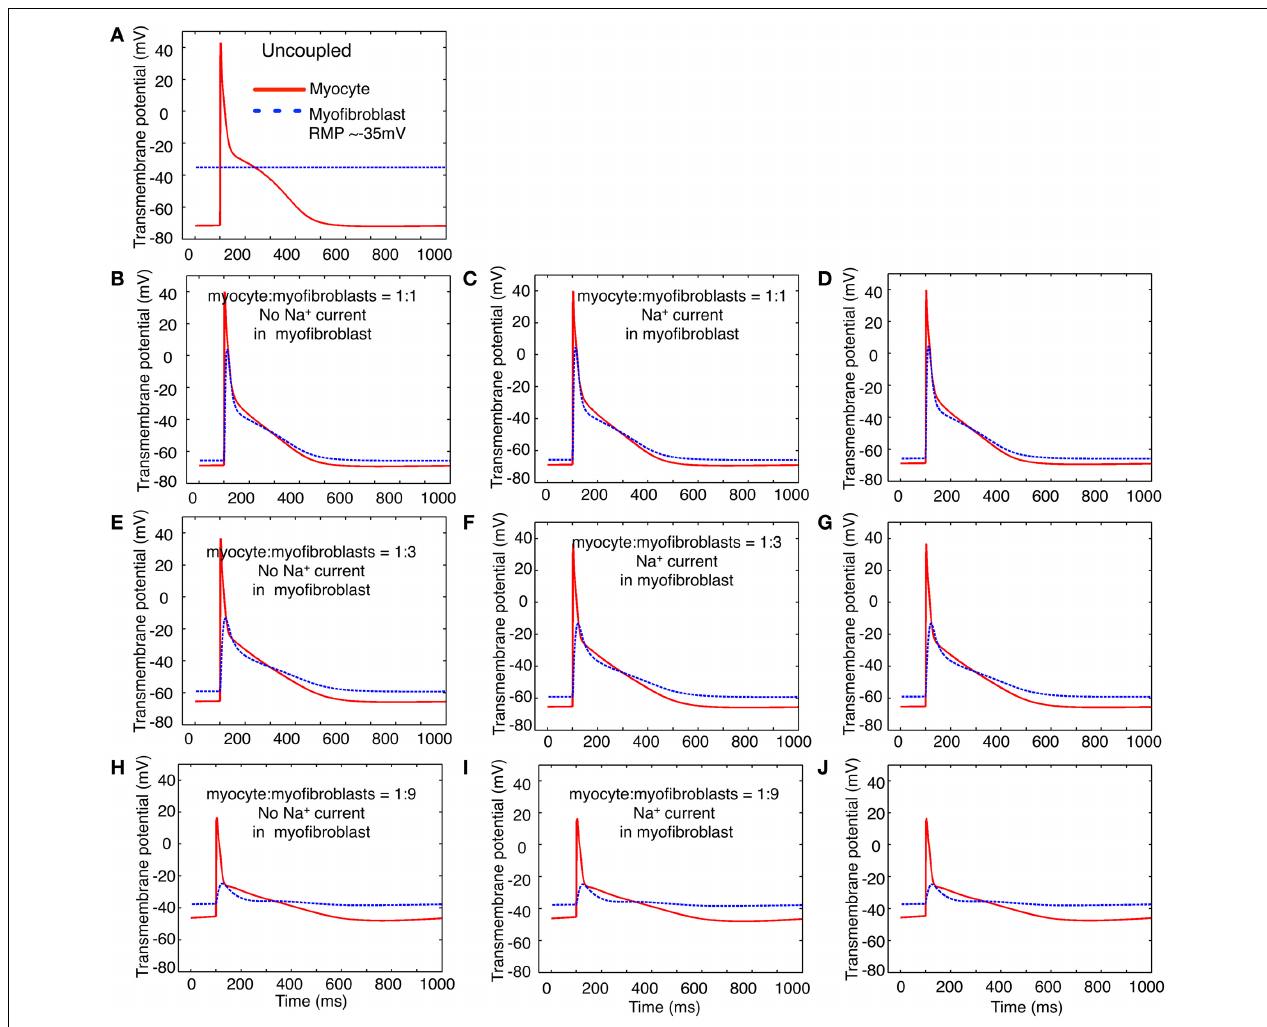
FIGURE 7 | Illustration of the effects of coupling selected numbers of myofibroblasts to 1 human atrial myocyte using an in silico hybrid mathematical model similar to the one first described by Maleckar et al. (2009a) when assuming a myofibroblast resting potential of − 35 or − 65mV. Panel (A) shows the human atrial myocyte action potential (red) and the myofibroblast at a resting potential of − 35mV, prior to these cells being coupled through a linear intercellular conductance of 0.5 nS. The remainder of this Figure is arranged in three rows. Panels (B–D) illustrate responses obtained when the myocyte to myofibroblast ratio is 1:1, panels (E–G) were computed based on a myocyte to myofibroblast ratio of 1:3; and panels